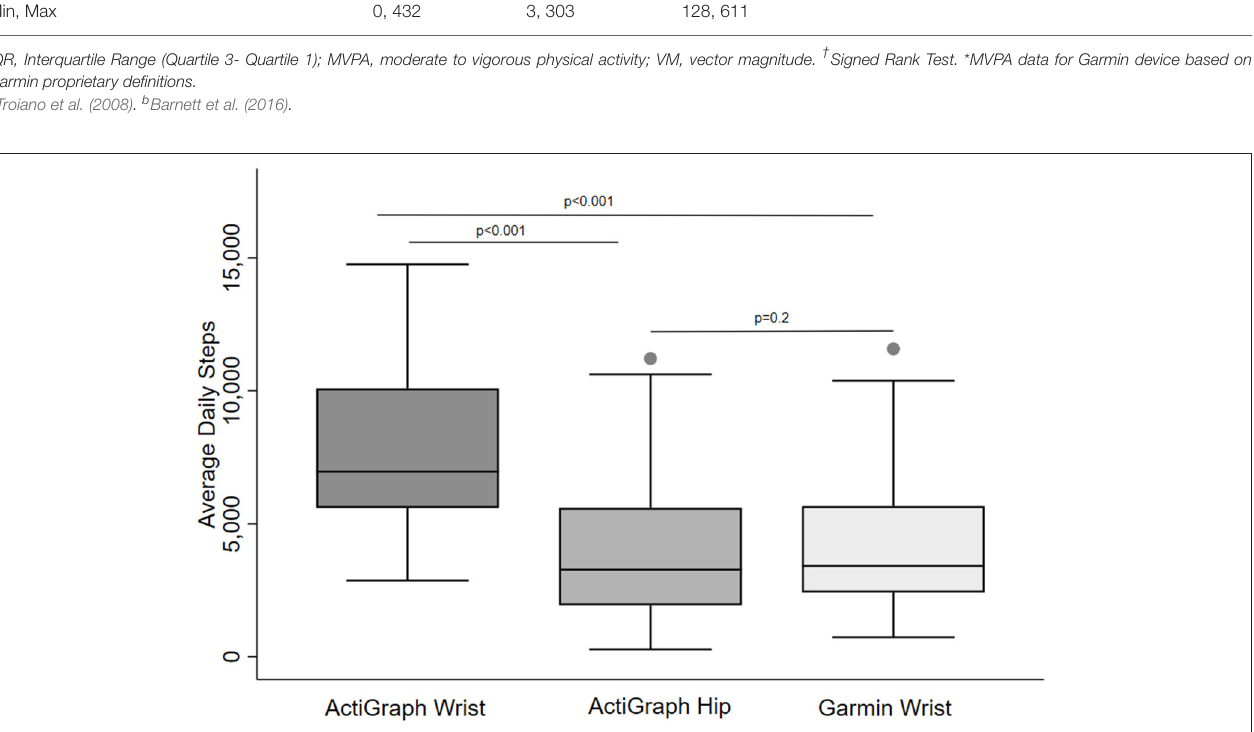
FIGURE 1 | Daily step count in older adults collected by different activity devices and wear locations. Pair-wise comparisons were tested by the Signed Rank